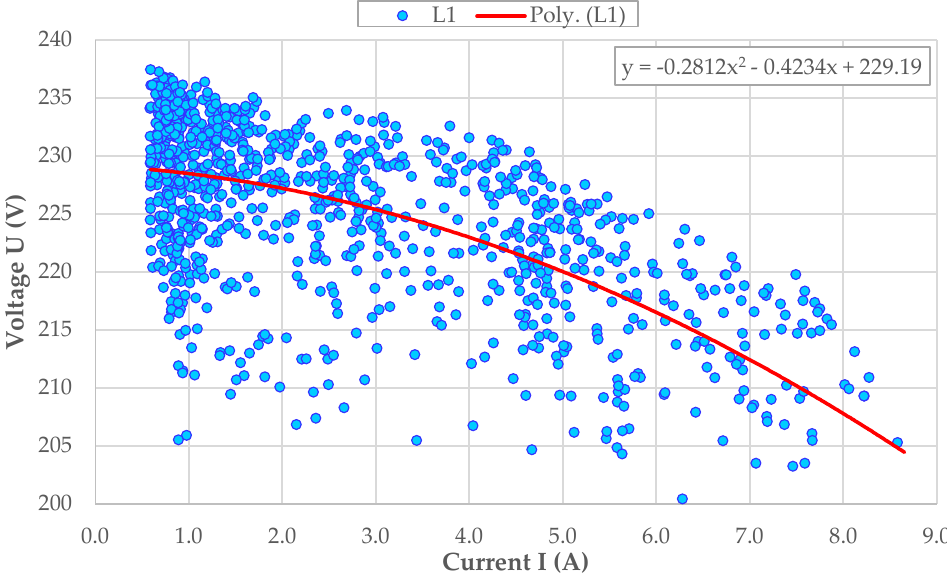
Figure 16. Phase L1 voltage–current curve with polynomial function describing the voltage drop dependency from the capacity of the load based on measurements in Object 3.